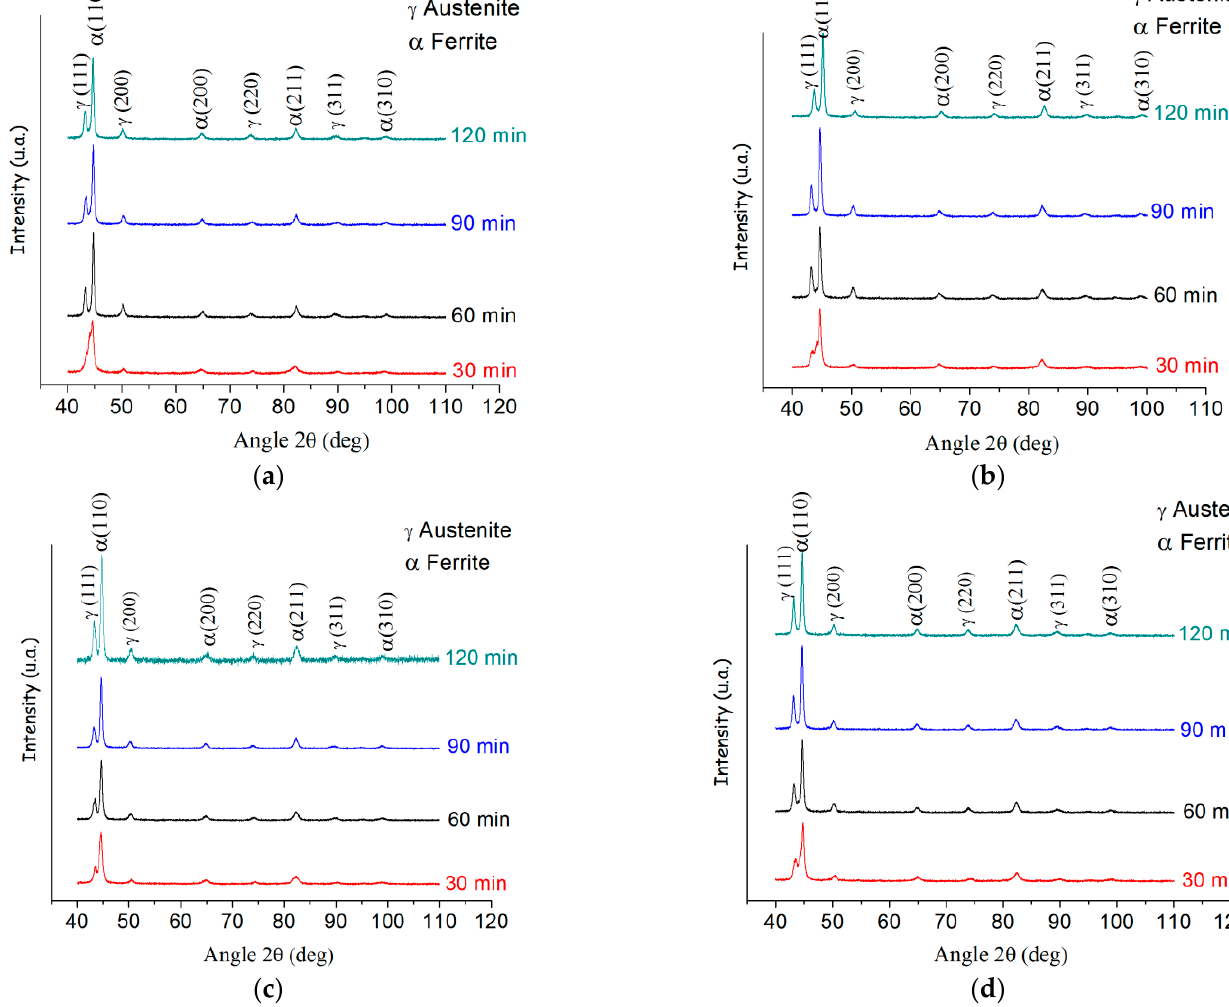
Figure 8. X ‐ ray diffraction patterns corresponding to the samples ( a ) ADI ‐ 0.2V ‐ 265, ( b ) ADI ‐ 0.2V ‐ 305, ( c ) ADI ‐ 0.3V ‐ 265, Figure 8. X-ray diffraction patterns corresponding to the samples ( a ) ADI-0.2V-265, ( b ) ADI-0.2V-305, ( c ) ADI-0.3V-265, and and ( d ) ADI ‐ 0.3V ‐ 305. ( d ) ADI-0.3V-305.